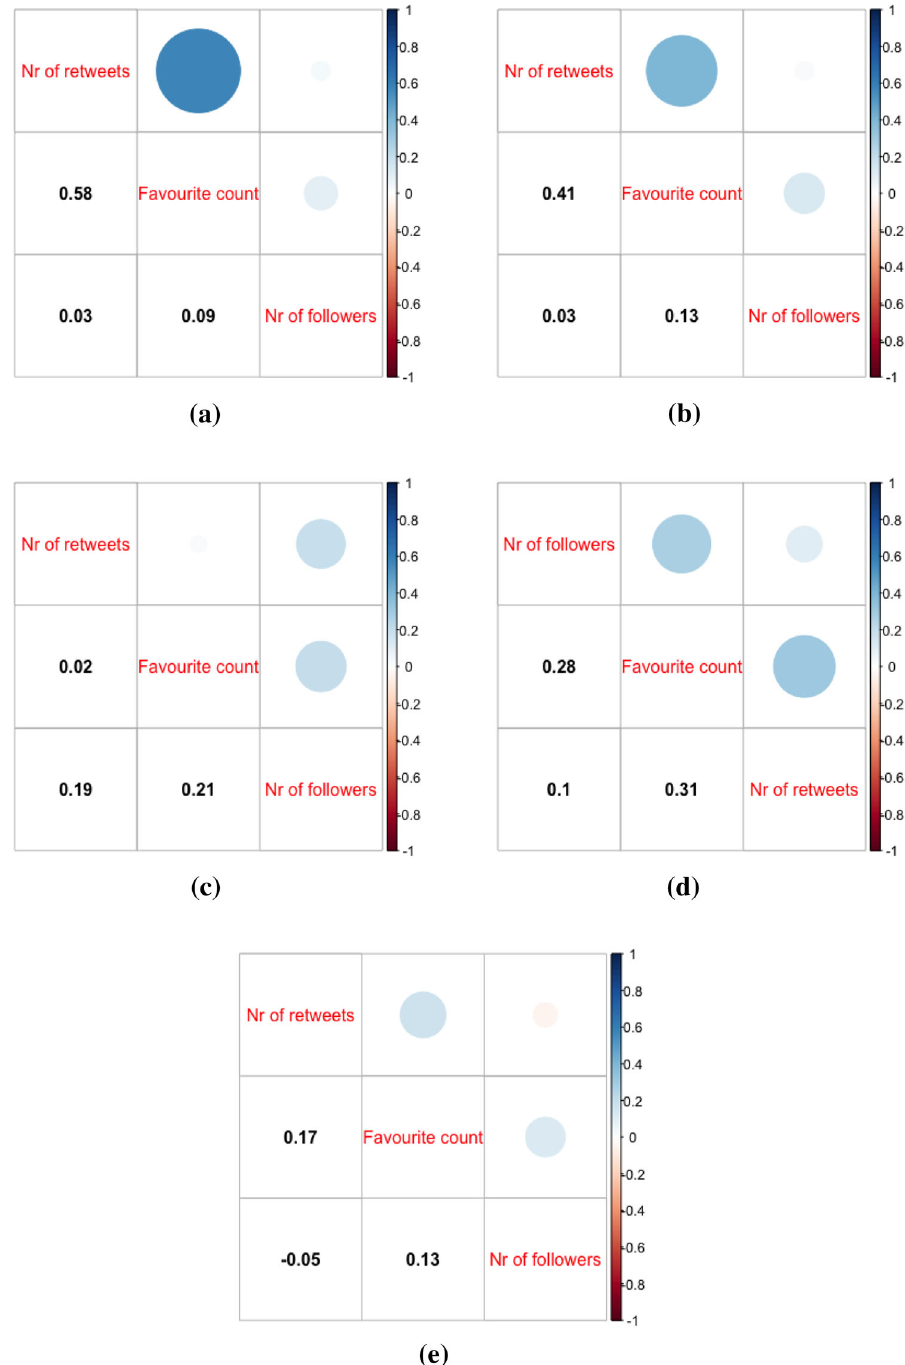
parameters, a Trump , b Obama , c La La Land , d The Voice